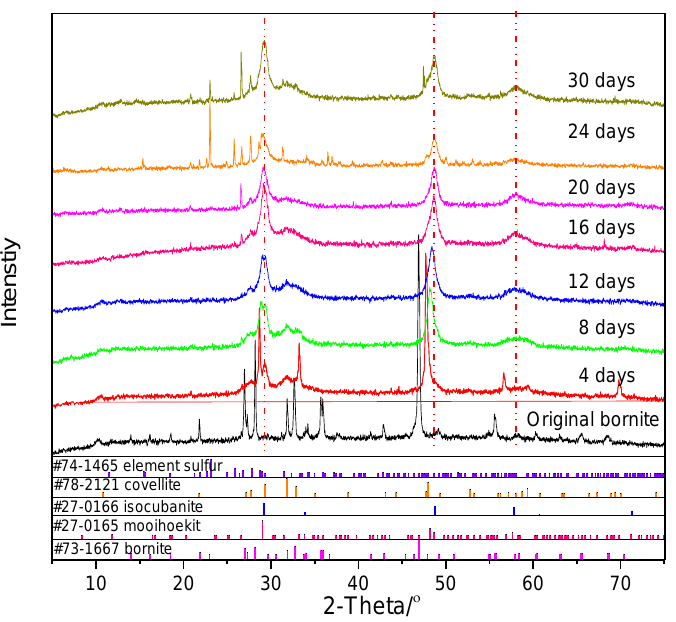
Figure 7. X-ray powder diffraction analysis of leached residues by L. ferriphilum.